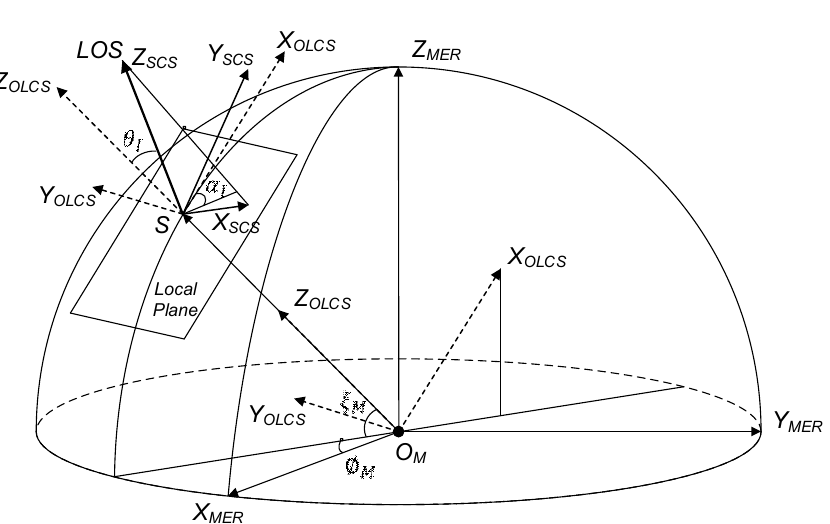
Figure 1. Coordinate transforms on the lunar sphere (the difference between the mean-Earth/rotation-axis (MER) and principle axis (PA) are not distinguished; thus, they are both presented by the Selenocentric Body-fixed Coordinate System (SBCS) in the figure). The relation between the sensor’s position and pointing direction is given by a series of transformation and an intersection. The flow chart of simulation is presented in section 4. The